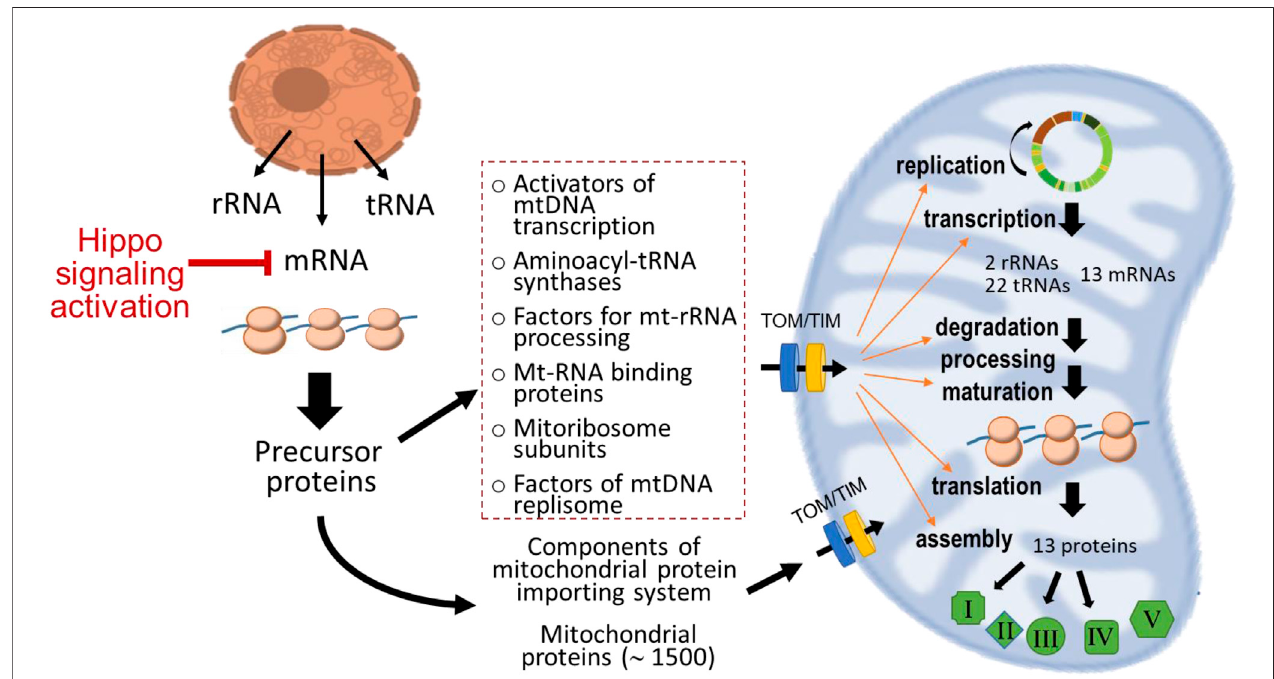
FIGURE 8 | Diagram depicting classes of nDNA-encoded genes and proteins that form the nDNA-mtDNA axis. Except the 13 proteins encoded in mtDNA, all mitochondrial localized proteins are nDNA-encoded and synthesized in the cytosol. These proteins are then transported into mitochondria through the operation of specialized protein-importing machinery and ultimately localize at various sites within mitochondria. The dotted-line rectangle indicates groups of nDNA-encoded proteinsformingthenDNA-mtDNAaxisgoverningtranscriptionandtranslationofmtDNA-encodedgenes.IntheDCMmodelstudied,activationofHipposignaling pathway suppressed nDNA-encoded mitochondrial genes that further interferes with this axis exacerbating mitochondrial dysfunction.